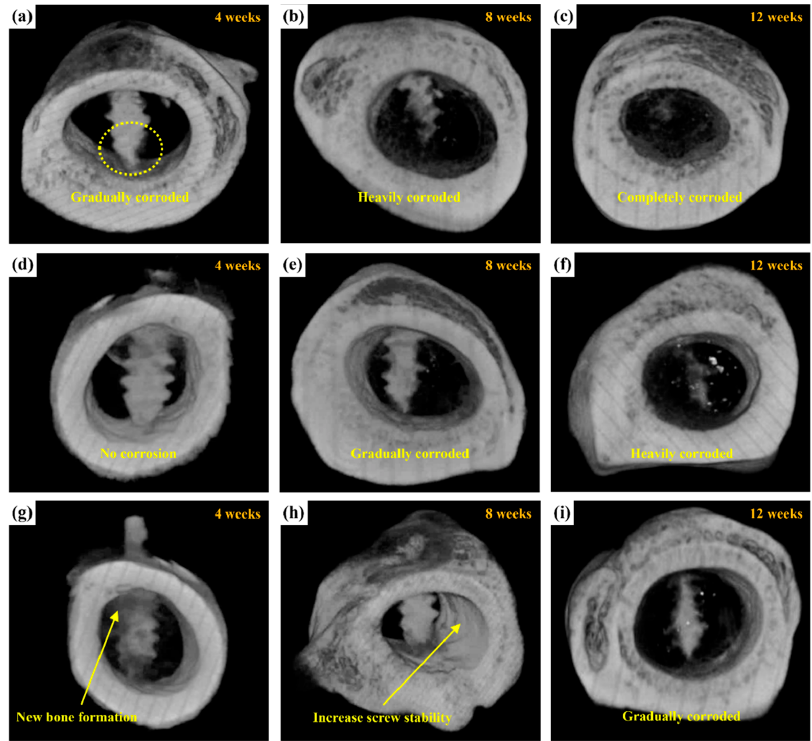
Figure 14. μ CT reconstructed images showing the degradation processes of ZK60 bone screw after implantation for 4, 8, and 12 weeks: ( a – c ) untreated, ( d – f ) MAO-treated, and ( g – i ) MAOCa-treated screw.